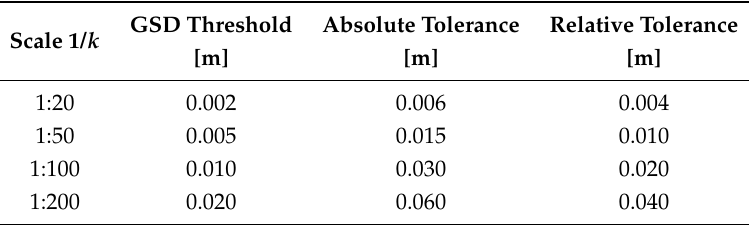
Table 2. GSD and Tolerance.